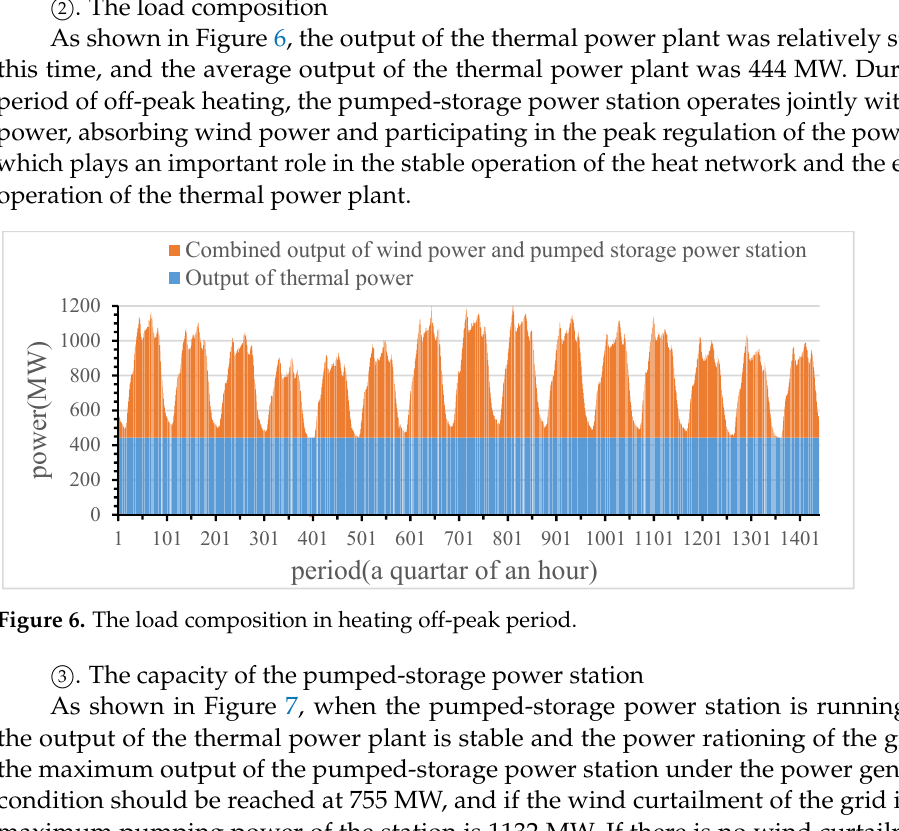
imum pumping power of the station is 1132 MW. If there is no wind curtailment or power rationing, the pumped-storage power station should have a capacity of 1132 MW.